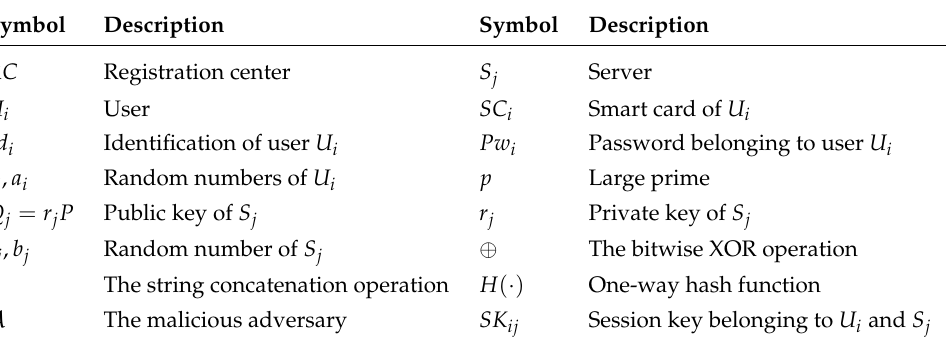
Table 1. Notations and their